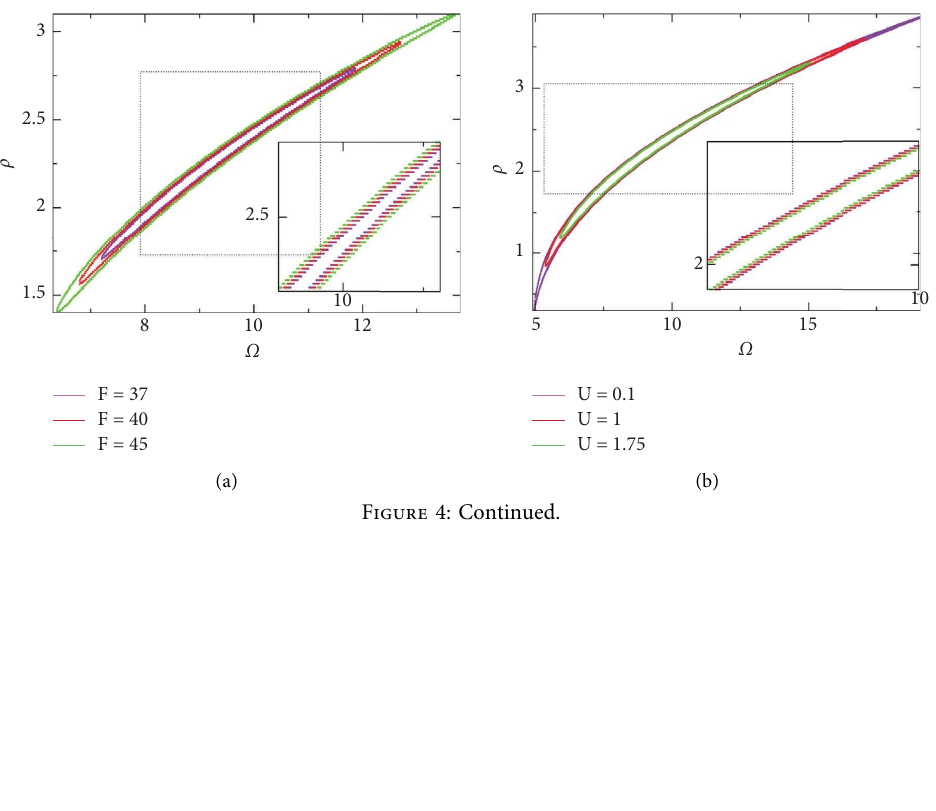
� 0 . 01 ; C � 0 . 00001. 1 2